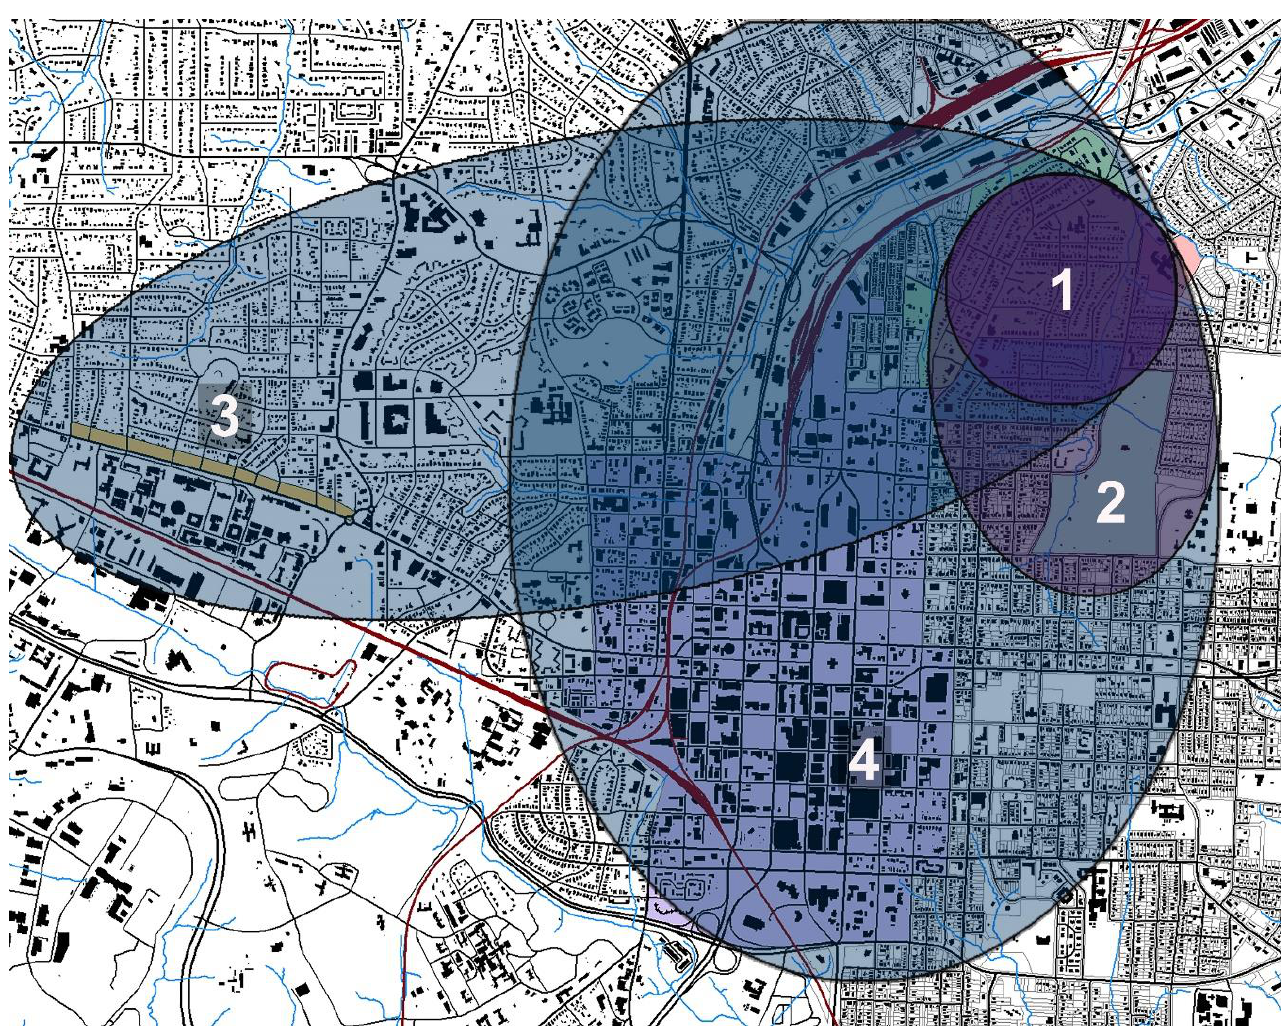
Figure 2. The creek, elementary school, and most of the boys’ homes appear in Zone 1, approximately half a mile radius. From the creek, the boys ventured to Oakwood Cemetery [44] .